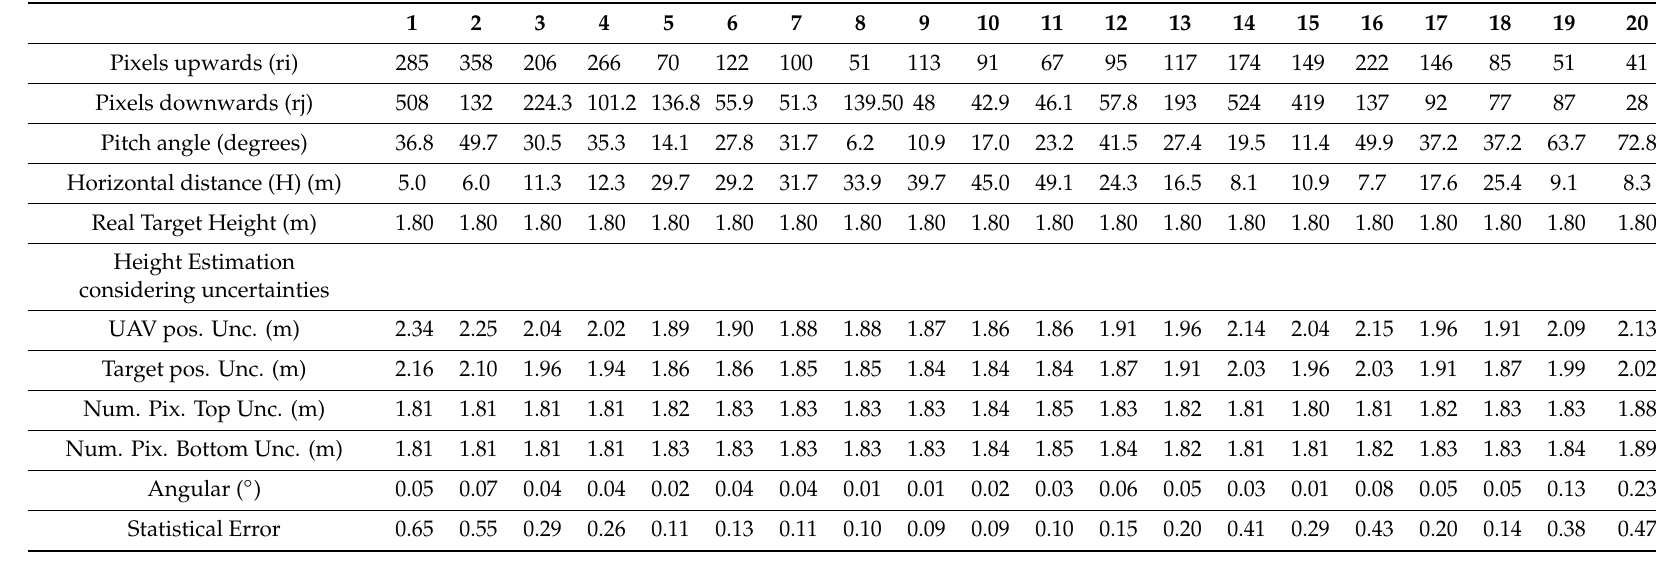
Table 1. The 20 cases with a random position of the UAV generated artificially. The table reports the parameters (pixels upwards and downwards for image center, pitch angle and horizontal camera-to-target distance) with a target of 1.80 m. The table also reports the calculated height of the target when uncertainties such as UAV positional uncertainty (1.5 m), target position (1.0 m) and the number of pixels at top and bottom (3 pixels for both). Each uncertainty was isolated and treated separately to calculate the resulting height. Finally, the table reports also the statistical error obtained using the formula in (22). 1